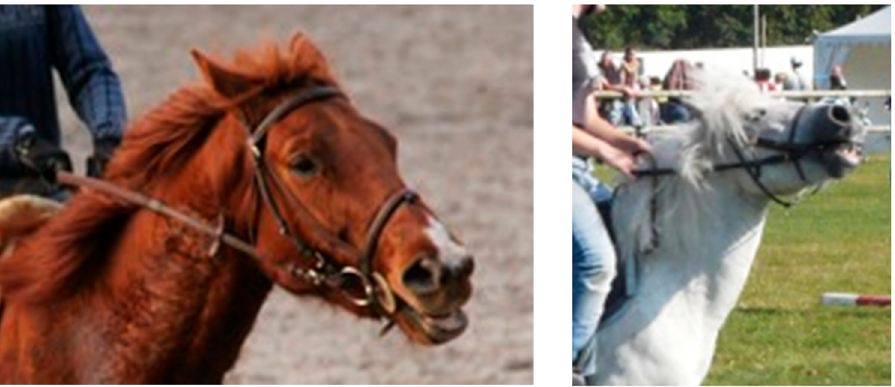
Figure 3. High hands and tensed reins are associated with high neck and undesirable behaviors in horses, such as mouth opening. Photo credit: Martine Hausberger.